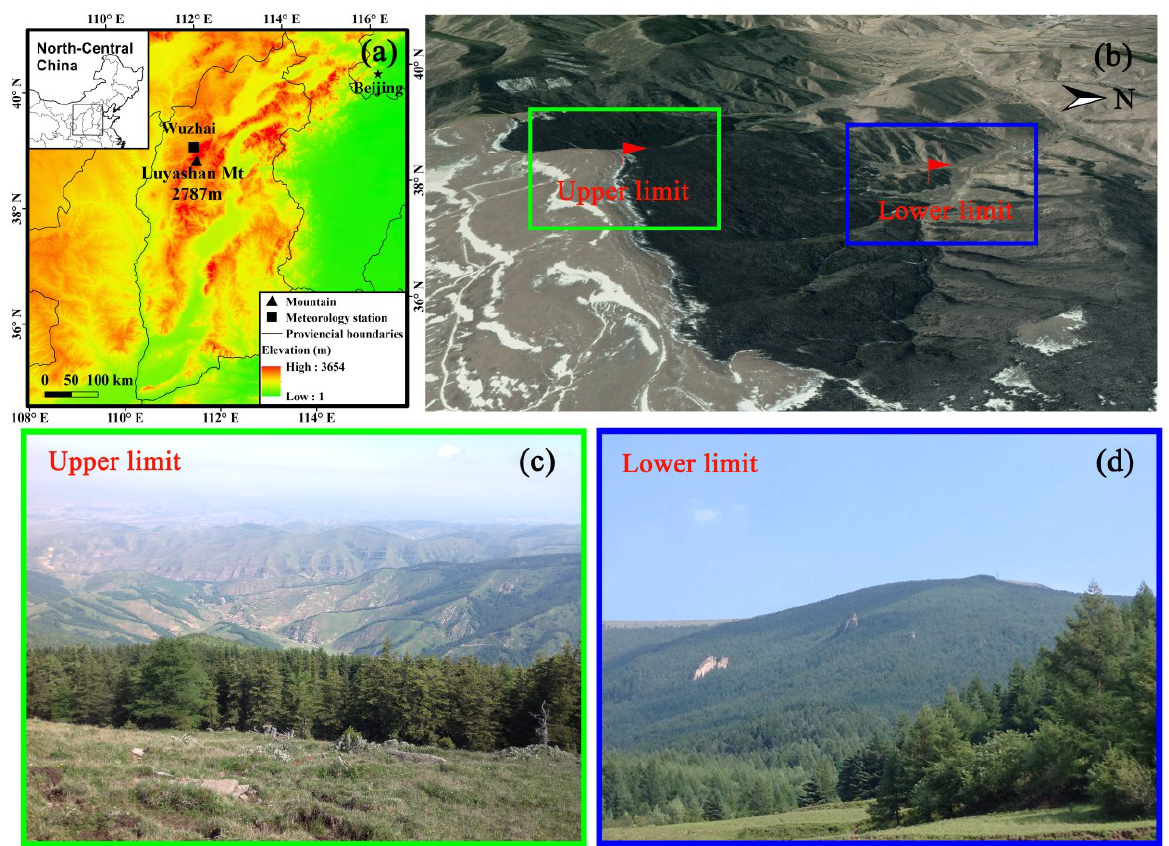
Figure 1. Location of study area in north-central China ( a ) and the landscape of the study area ( b – d